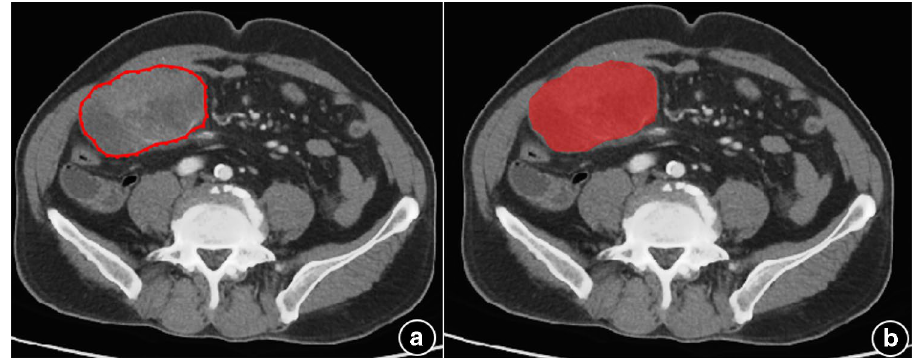
Figure 1. The image-processing software ITK ⁃ SNAP was used to manually delineate tumor ROIs along the lesion fringes on all the layers containing the tumors through the enhanced-CT venous phase images, and then the images were merged into 3D ROI images